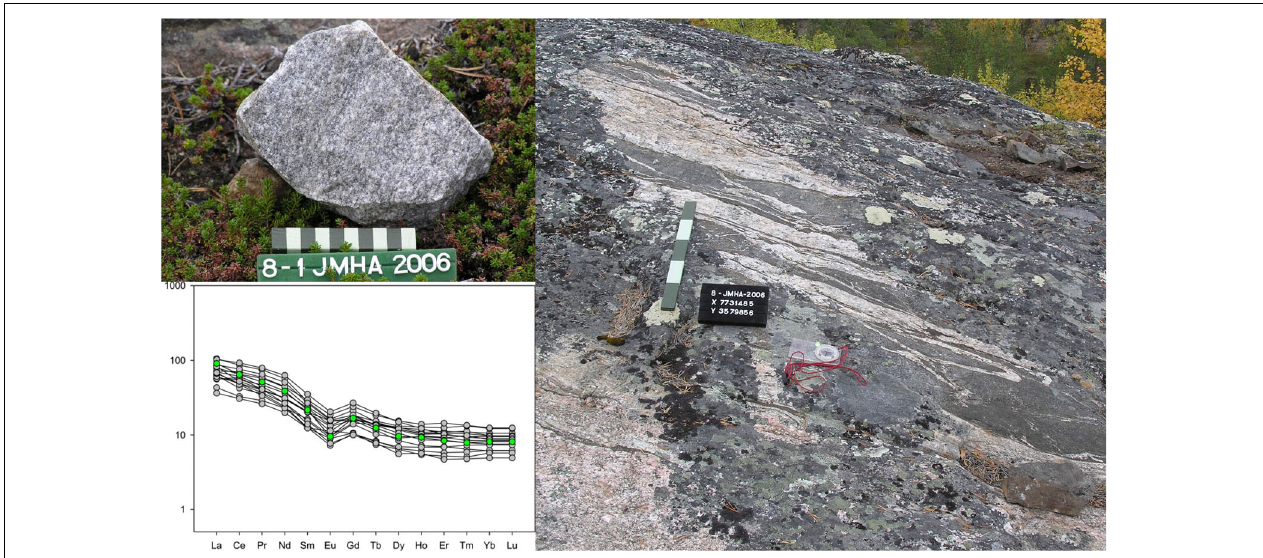
FIGURE 15 | REE patterns of high-HREE TTGs from the Lake Inari Complex ( Supplementary Table S1 ). The pattern indicated by green symbols is from a metatexite sample found in the same Näätämö area as diatexite in Figure 14 . Length of scale: hand specimen 10 cm, outcrop 50 cm.